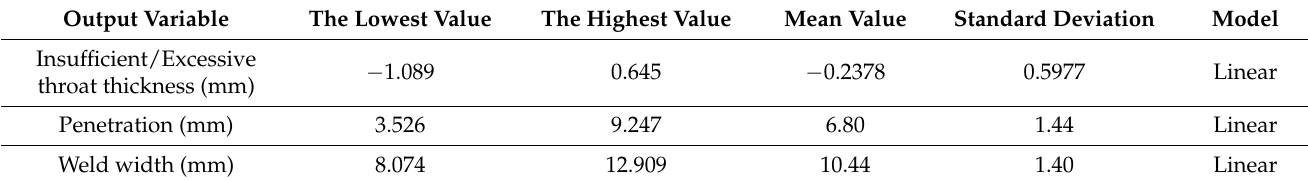
Table 7. Characteristic values of output variables for selected